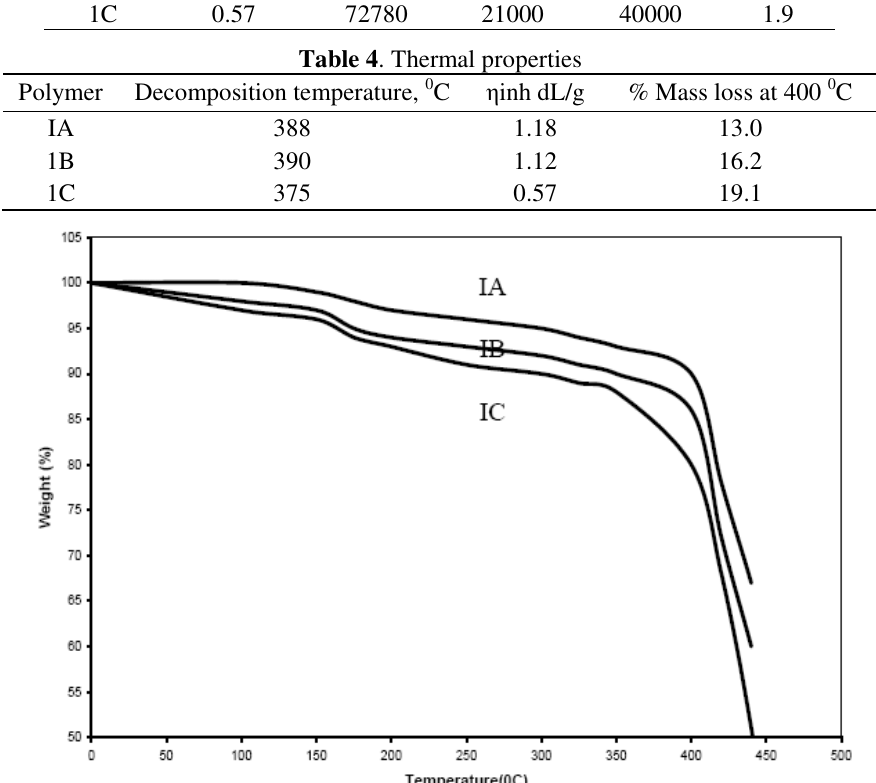
Figure 1 . TGA graph of all polymers with 1-6 bis (carboxymethyl)